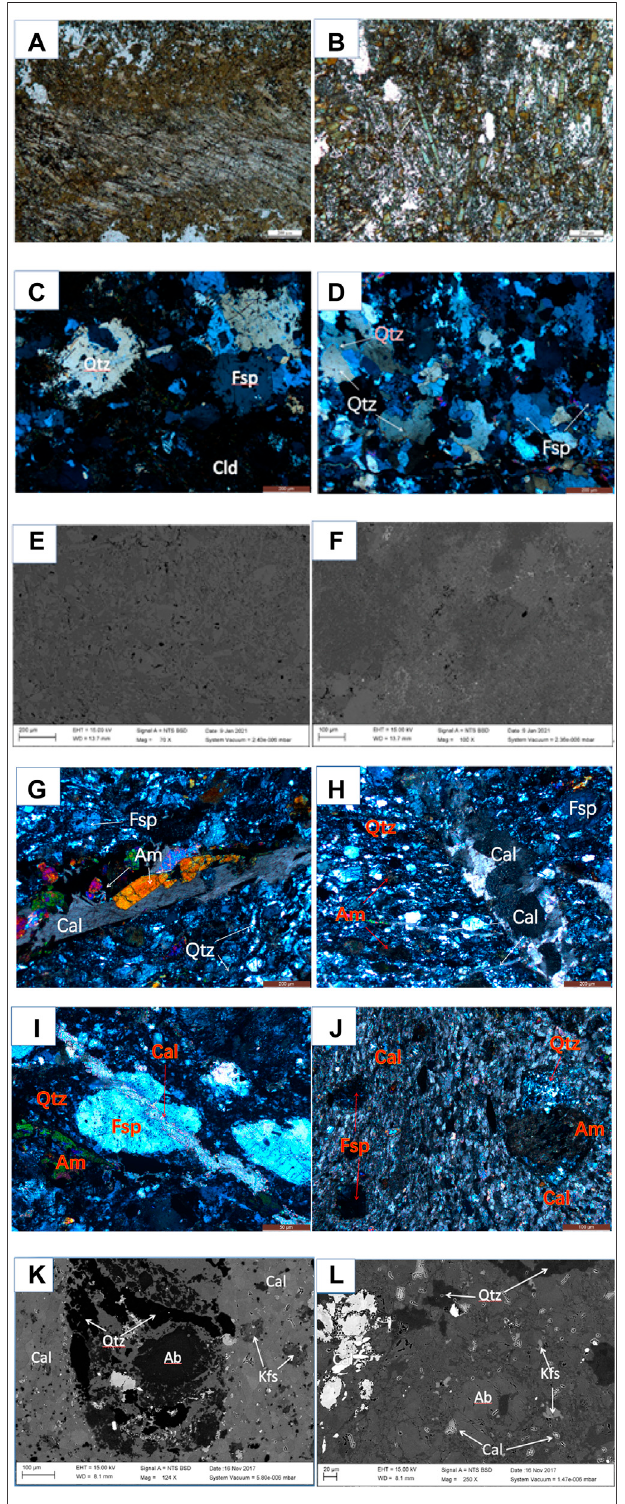
FIGURE 5 | Microstructure of pseudotachylyte and cataclasite under optical microscopy (OM) and scanning electron microscope (SEM). (A) and (B) images of Y11-1B under OM (crossed polarized light); (C) and (D) images